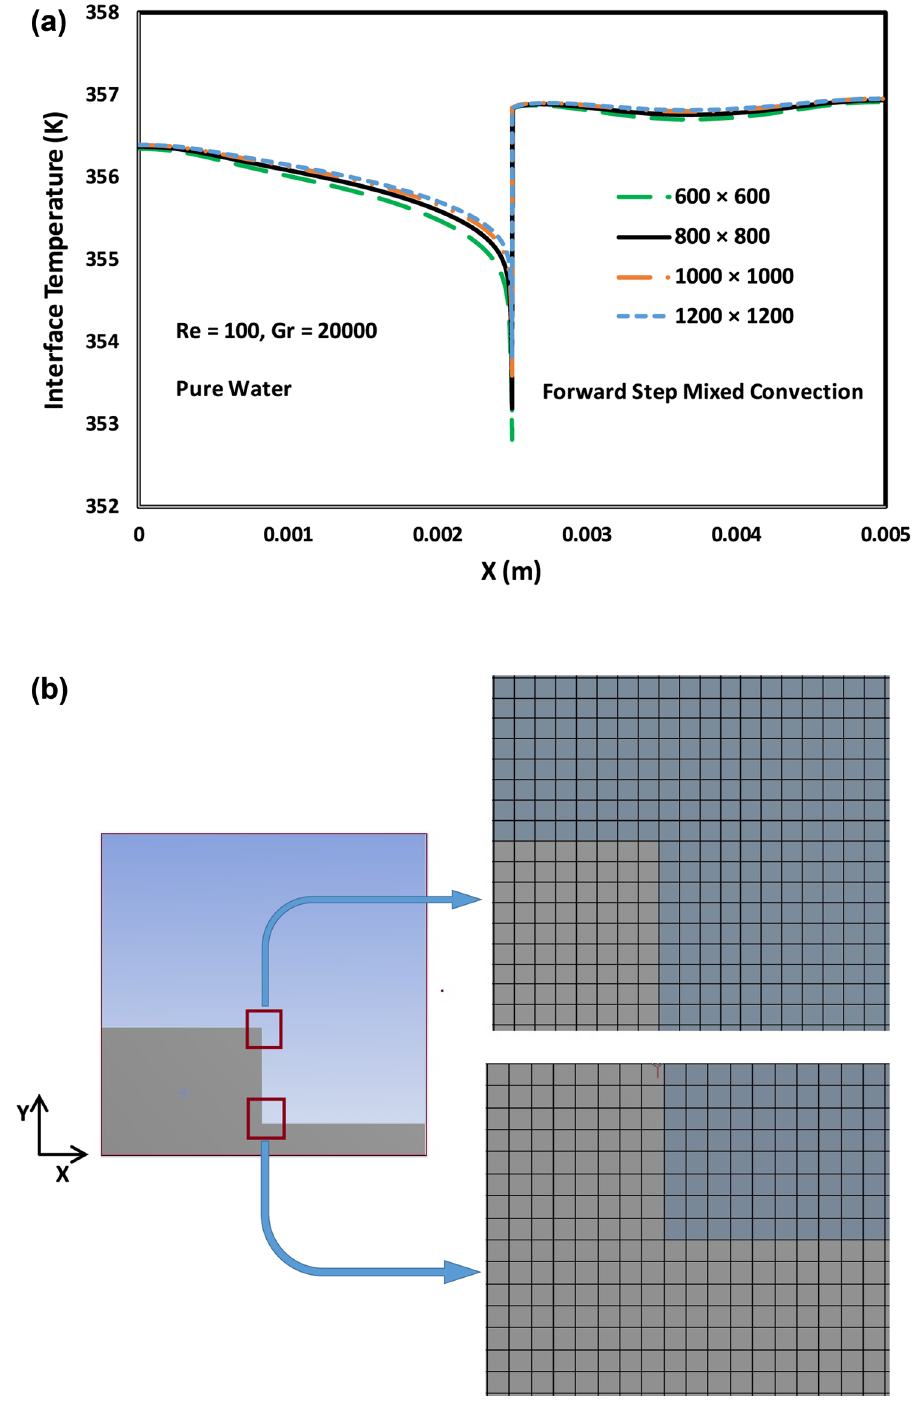
Fig. 2 a Grid independence test representing temperature along the solid–fluid interface of the lid-driven cavity in the case of pure water at Re = 100 and Gr = 20,000 in forward step, and b Grid distribution within the lid-driven cavity at two different locations repre- sented by small square boxes for 800 × 800 grid